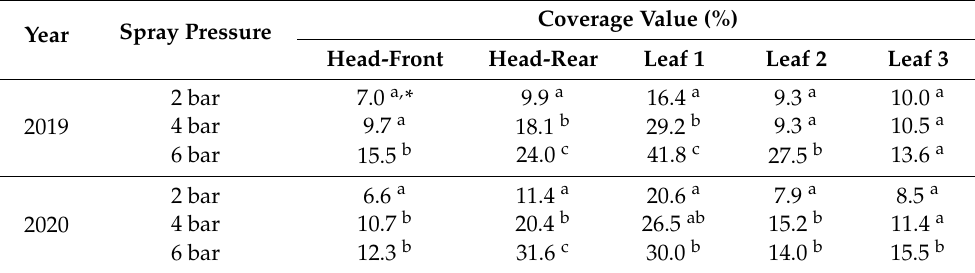
Table 1. Coverage value at different spraying pressures in 2019 and 2020.